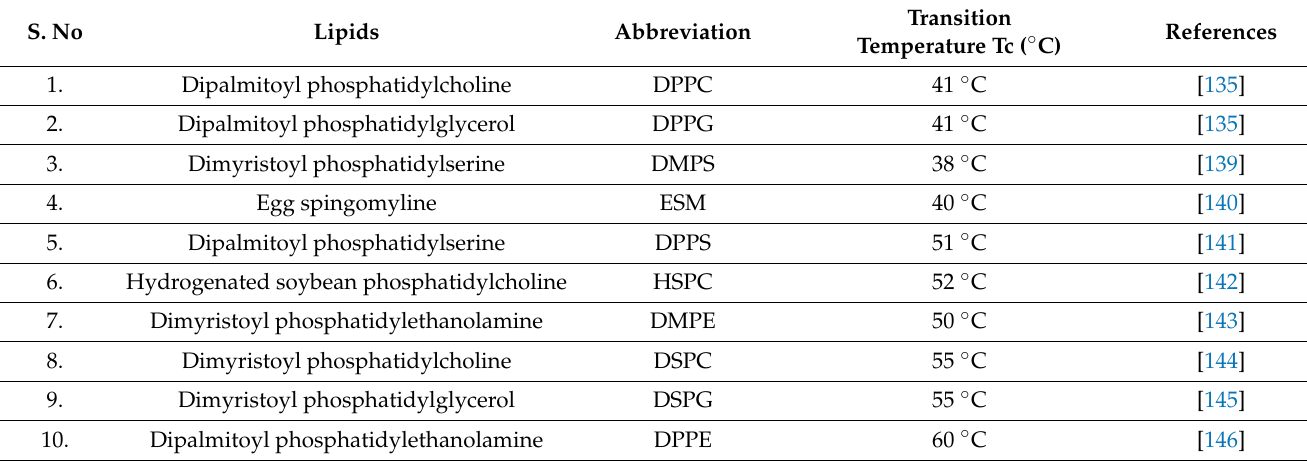
Table 3. Biocompatible Thermoresponsive Lipids and their Phase Transition